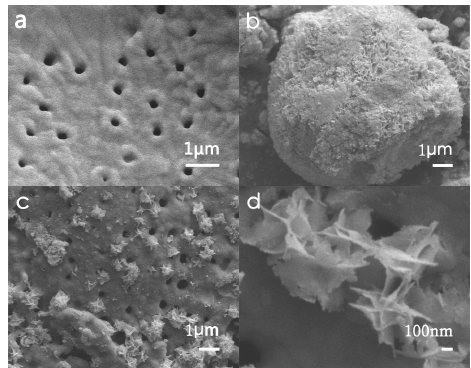
Figure 3. SEM images of: diatomite ( a ); Bi 2 MoO 6 ( b ); and B/D-70% with different magnifications ( c , d ).